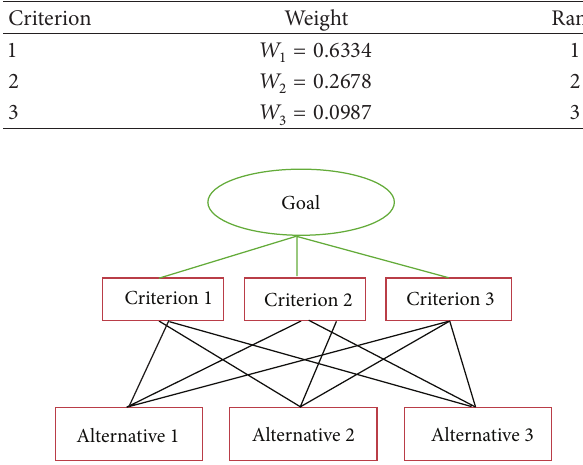
Figure 3: A hierarchical